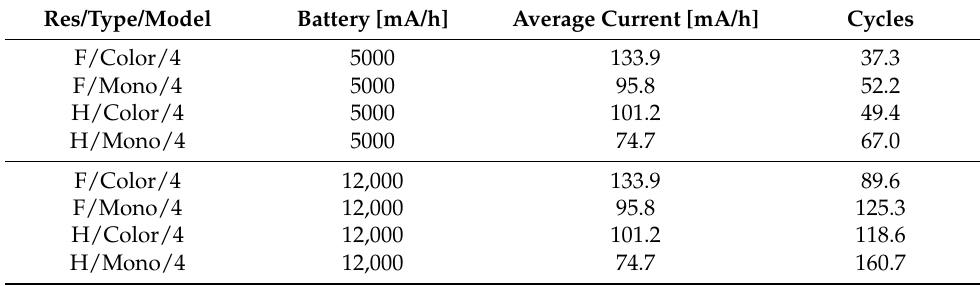
Table 2. Feasible measurement cycles with batteries of 5000 mA/h and 12,000